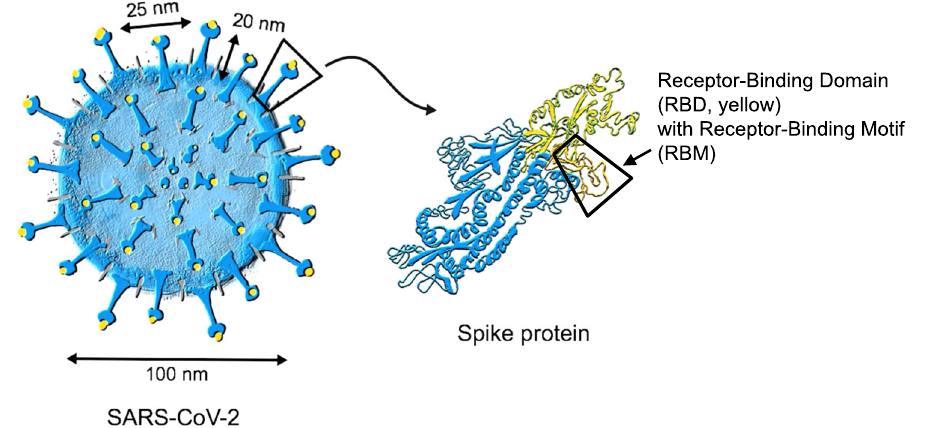
Fig. 1 Structure of SARS-CoV-2. Coronaviruses have their names from the typical spikes which are made of the spike (S) protein that is inserted in the lipid bilayer membrane of the virus. The receptor-binding domain (RBD) and its receptor-binding motif (RBM) enable interaction with the cell surface receptor ACE2 mediating entry of the virus into host cells. This can be blocked by neutralizing antibodies. Therefore, most neutralizing epitopes are located on RBD/RBM. Besides the S protein, SARS-CoV-2 has two further viral surface proteins (not shown): envelope (E) and matrix